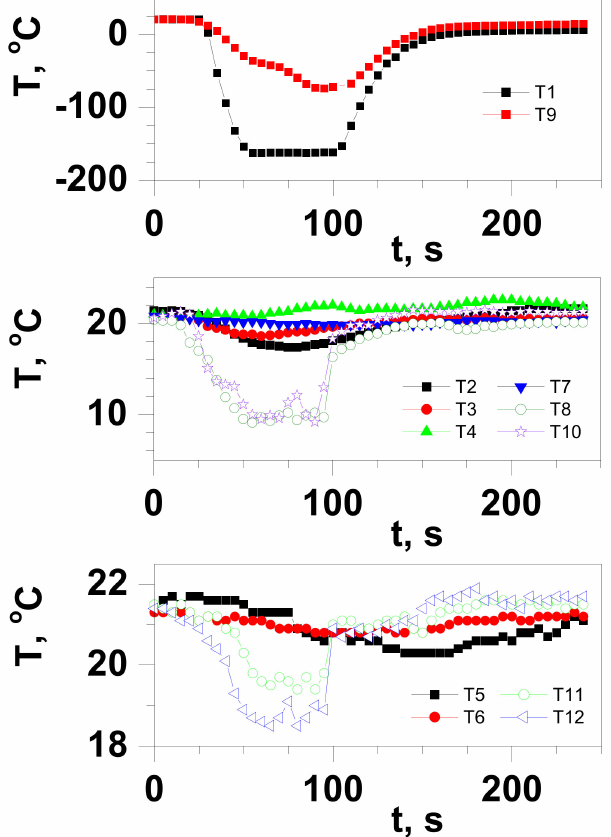
Figure 11. Temperature as a function of time for the thermocouple array presented in Figure 3. Atmospheric conditions of the measurement series 1: Q = 1.71 kg/s, T = 21.3 ◦ C, v = 0.52 m/s, RH = 47%, p = 1001.9 hPa. Release parameters: p out = 6 atm, t = 75 s, h = 0.75 m. The value of ∆ T max = 93.3 ◦ C (T min = − 73.8 ◦ C) indicates that the cloud